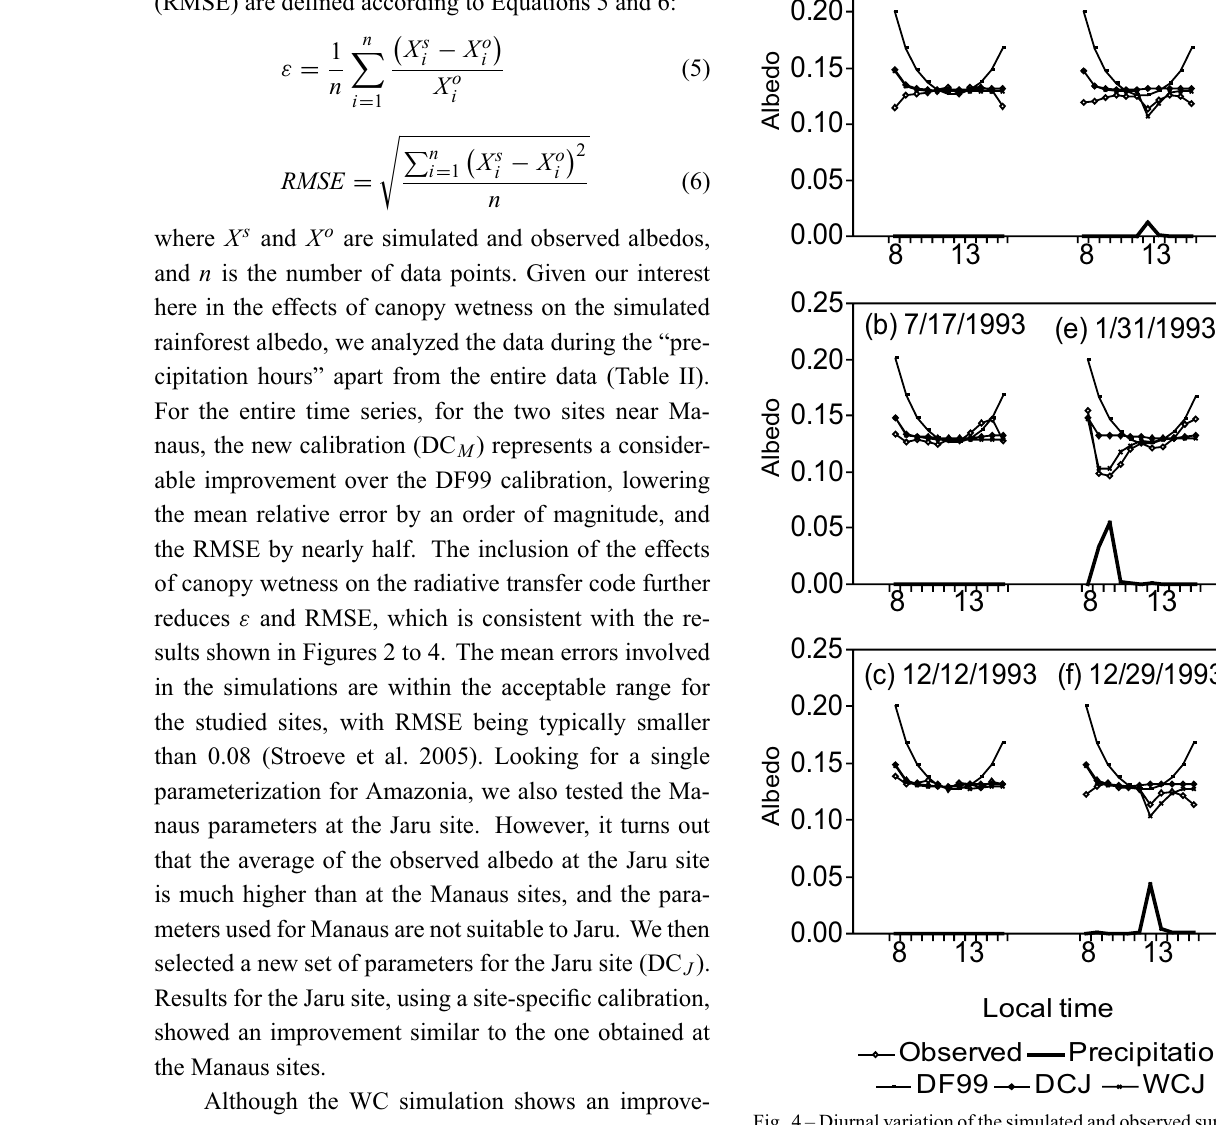
Fig. 4–Diurnalvariationofthesimulatedandobservedsurfacealbedo in the Jaru Reserve for the selected